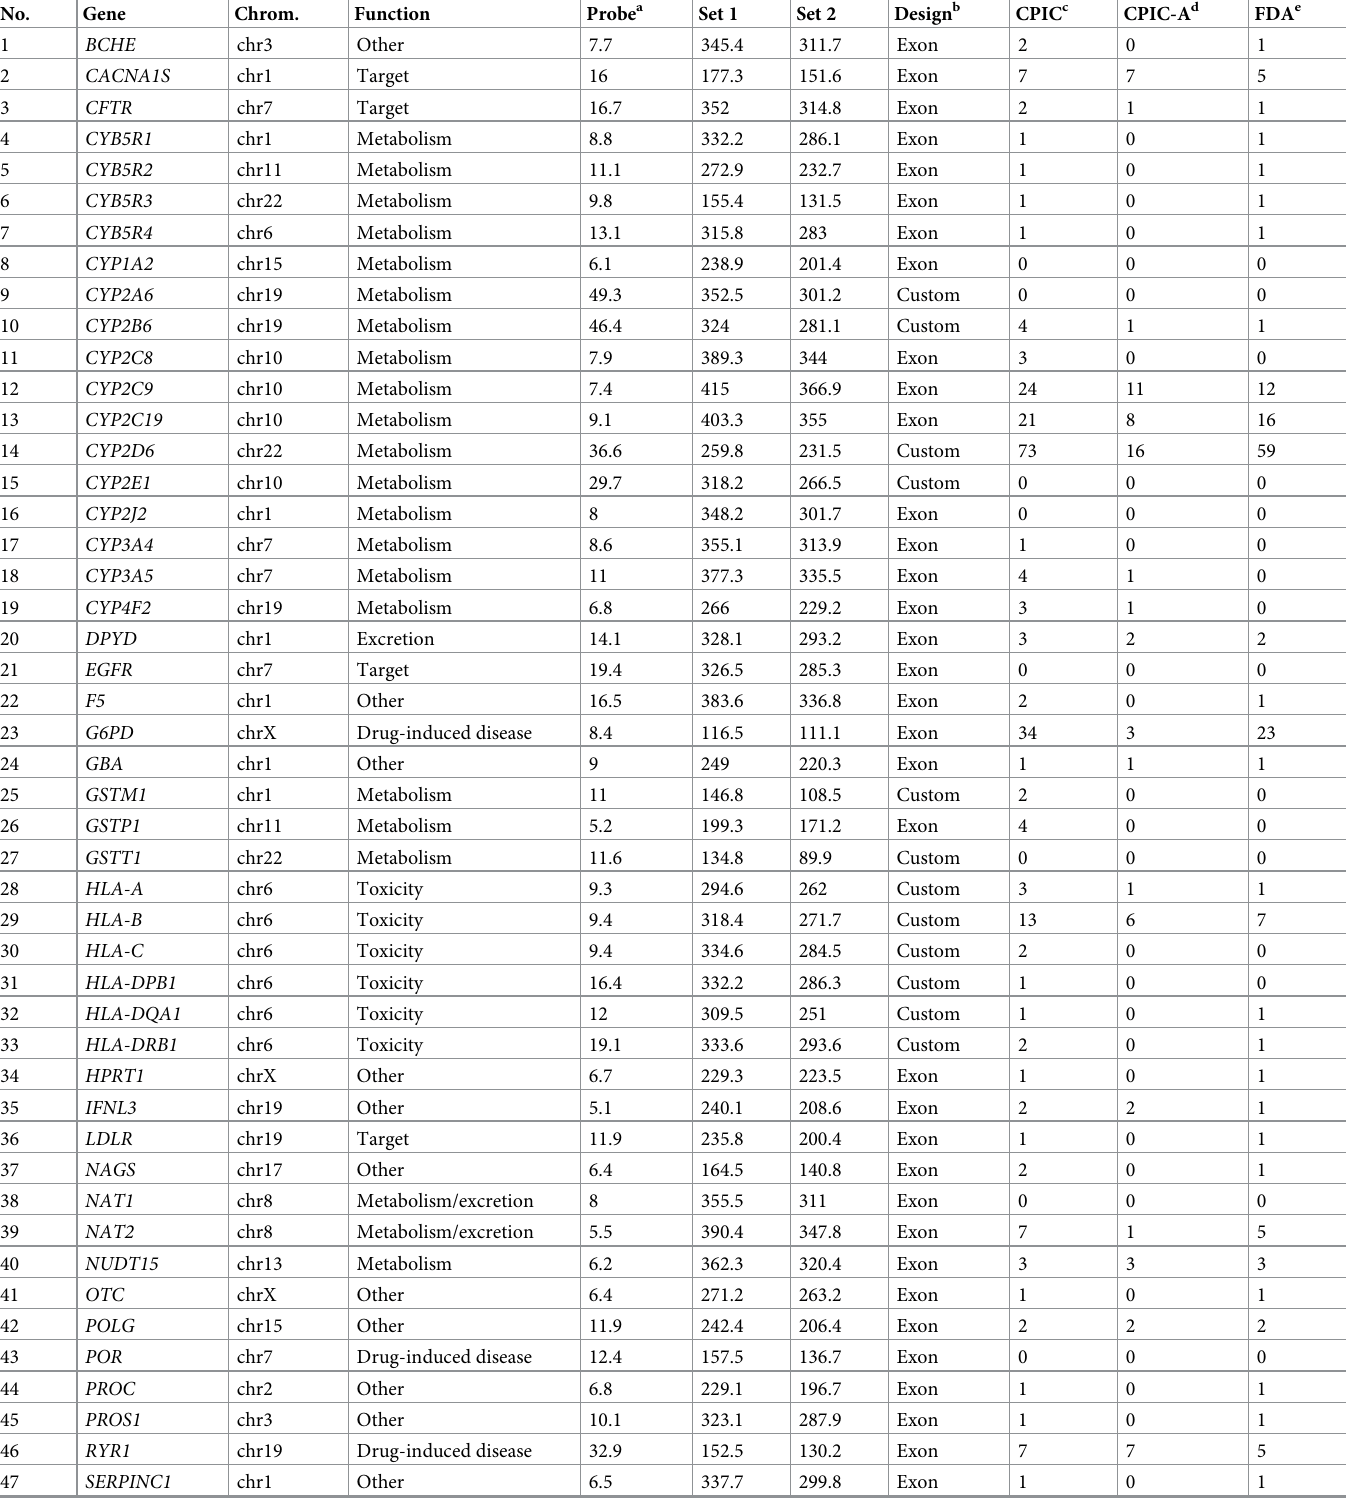
Table 1. Summary of 59 pharmacogenes targeted by ClinPharmSeq and their mean sequencing coverage for Set 1 and Set 2. No.